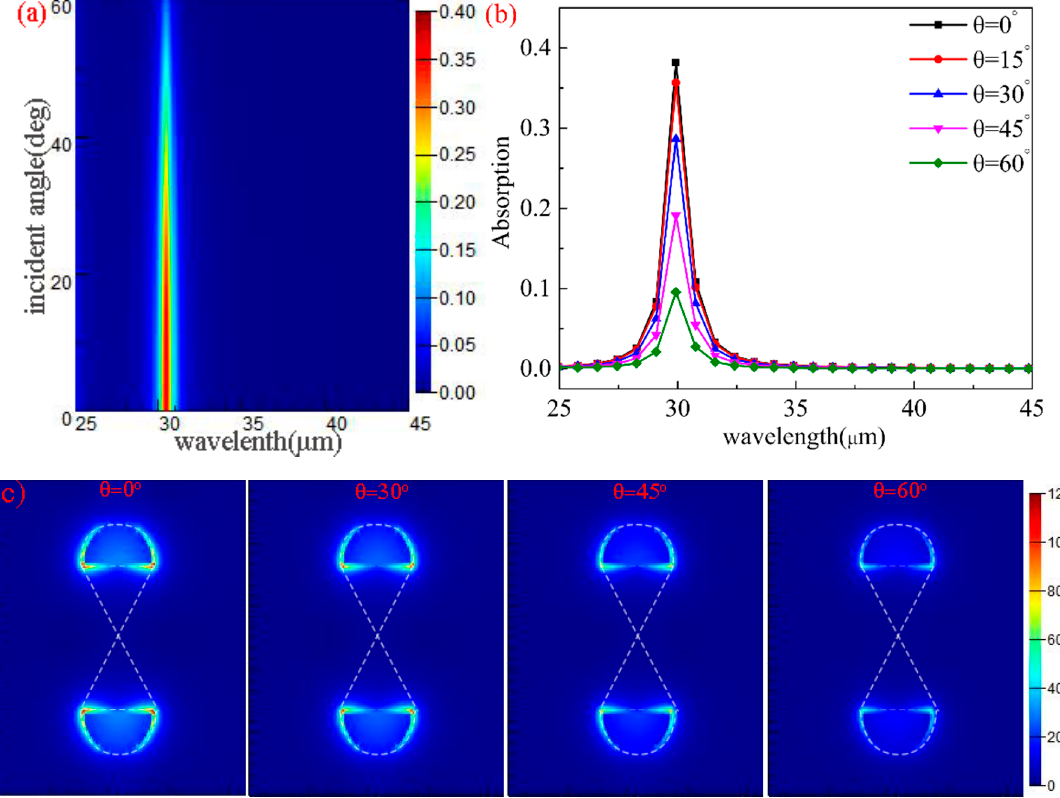
Figure 7. ( a , b ) The absorption spectra of the structure with different θ values. ( c ) The electric field distributions at the absorption peak for θ = 0 ◦ ,30 ◦ ,45 ◦ ,60 ◦